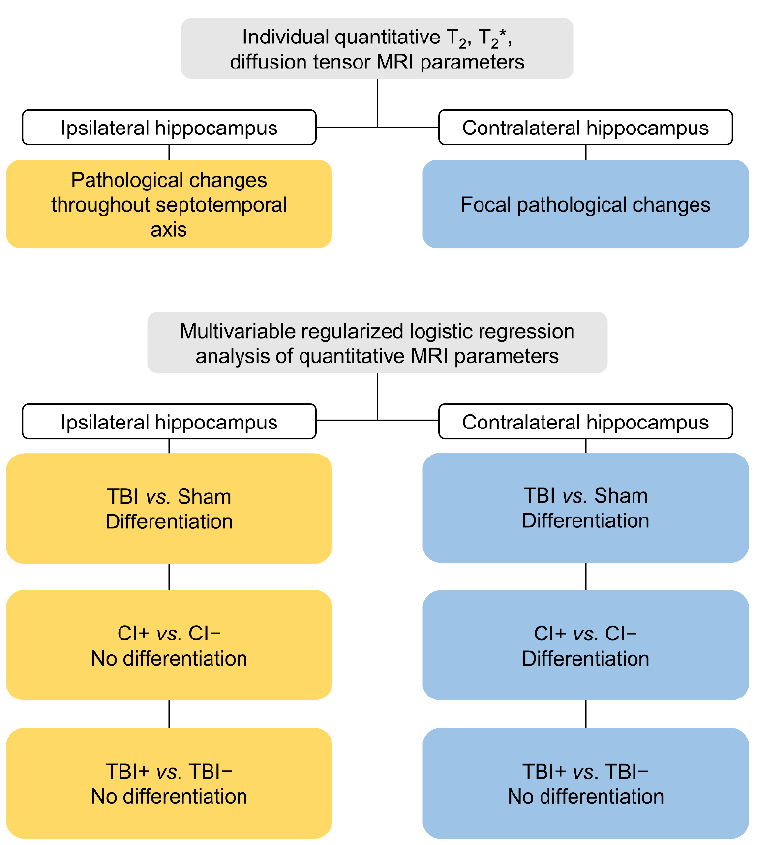
Figure 8. A summary of the main findings.